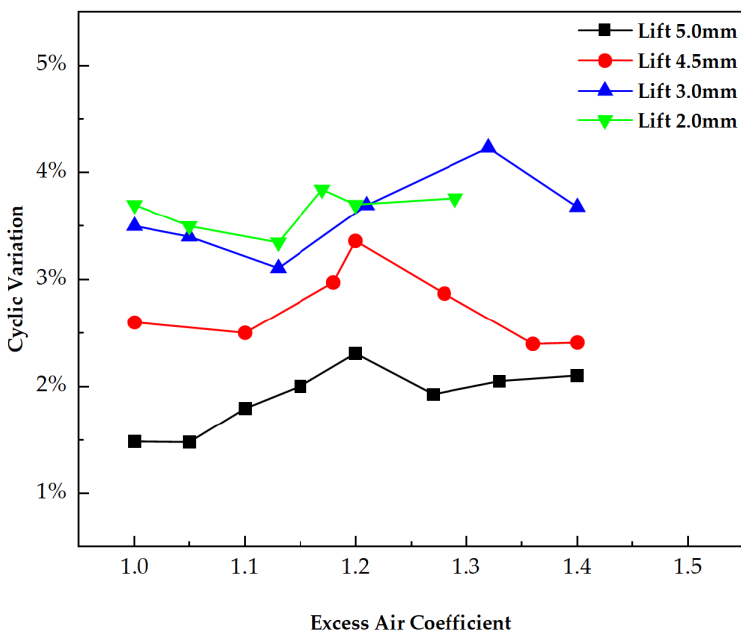
Figure 8. The cyclic variation of HCCI combustion under different exhaust valve lifts at 1200 rpm.